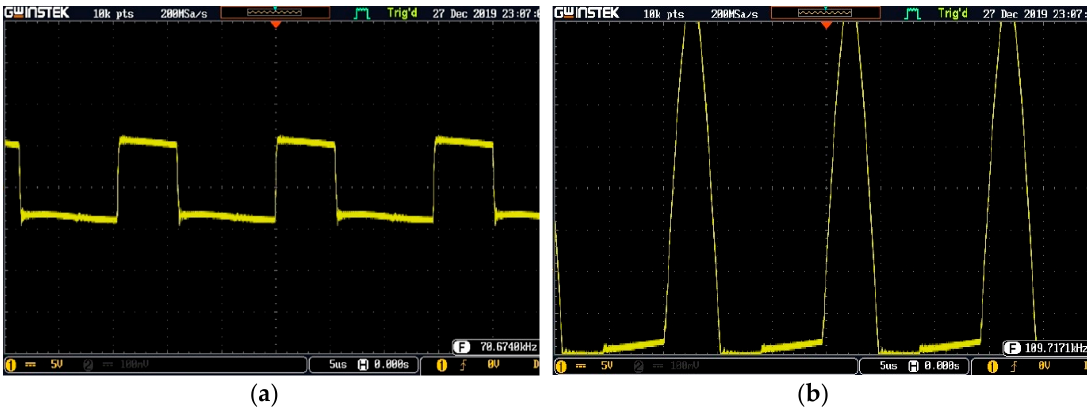
Figure 16. Measured waveform using oscilloscope: ( a ) the radio frequency power supply chip waveform; ( b ) operating frequency waveform.